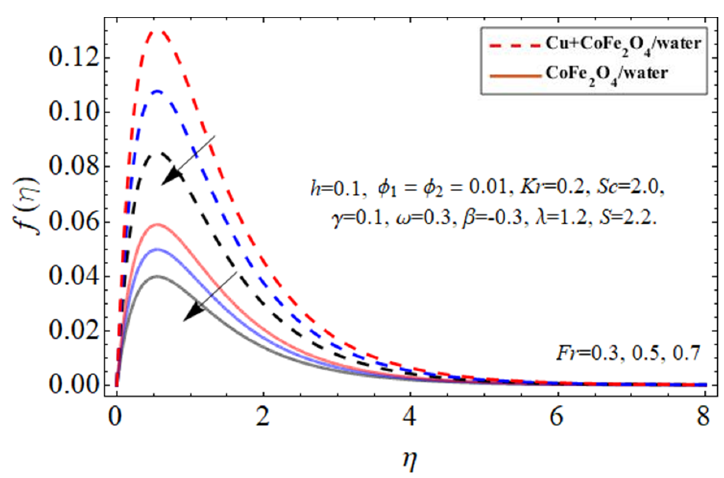
( ) η f Figure 6. The behavior of primary velocity against Forchhemier number Fr . Figure 6. The behavior of primary velocity f ( η ) against Forchhemier number Fr . Figures 7–9 particularize the radial velocity h ( η ) profile trend against the injection + β term, suction − β coefficient, and disk spinning constant ω influence, respectively.